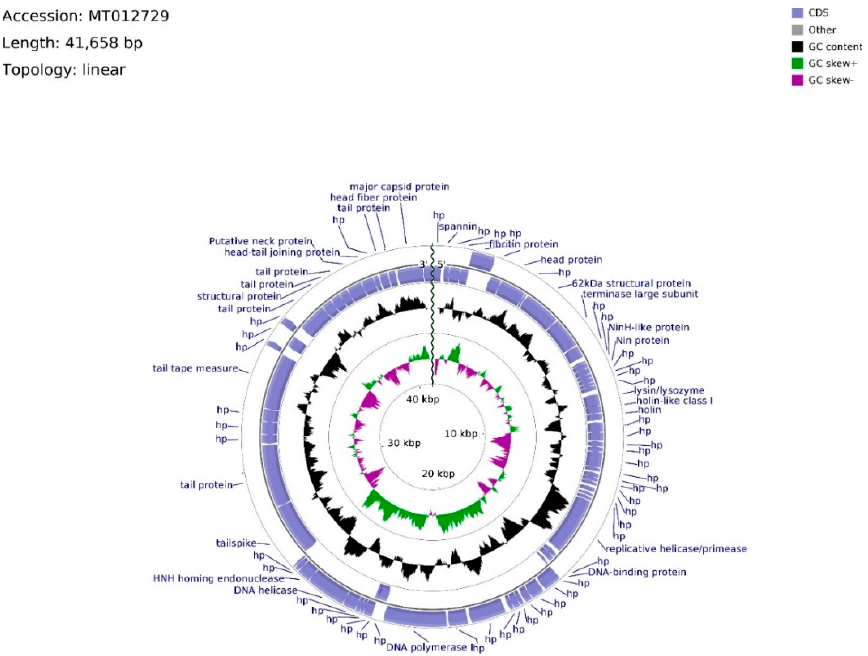
Figure 5. A schematic linear map of phage vB_Sen-TO17 genome (ends of the genome are indicated by the wavy line). The inner rings show genome location, GC skew + (green) and − (purple) and GC content (black). Two the most external rings show identified open reading frames (blue arrows) and results of genome annotation process.